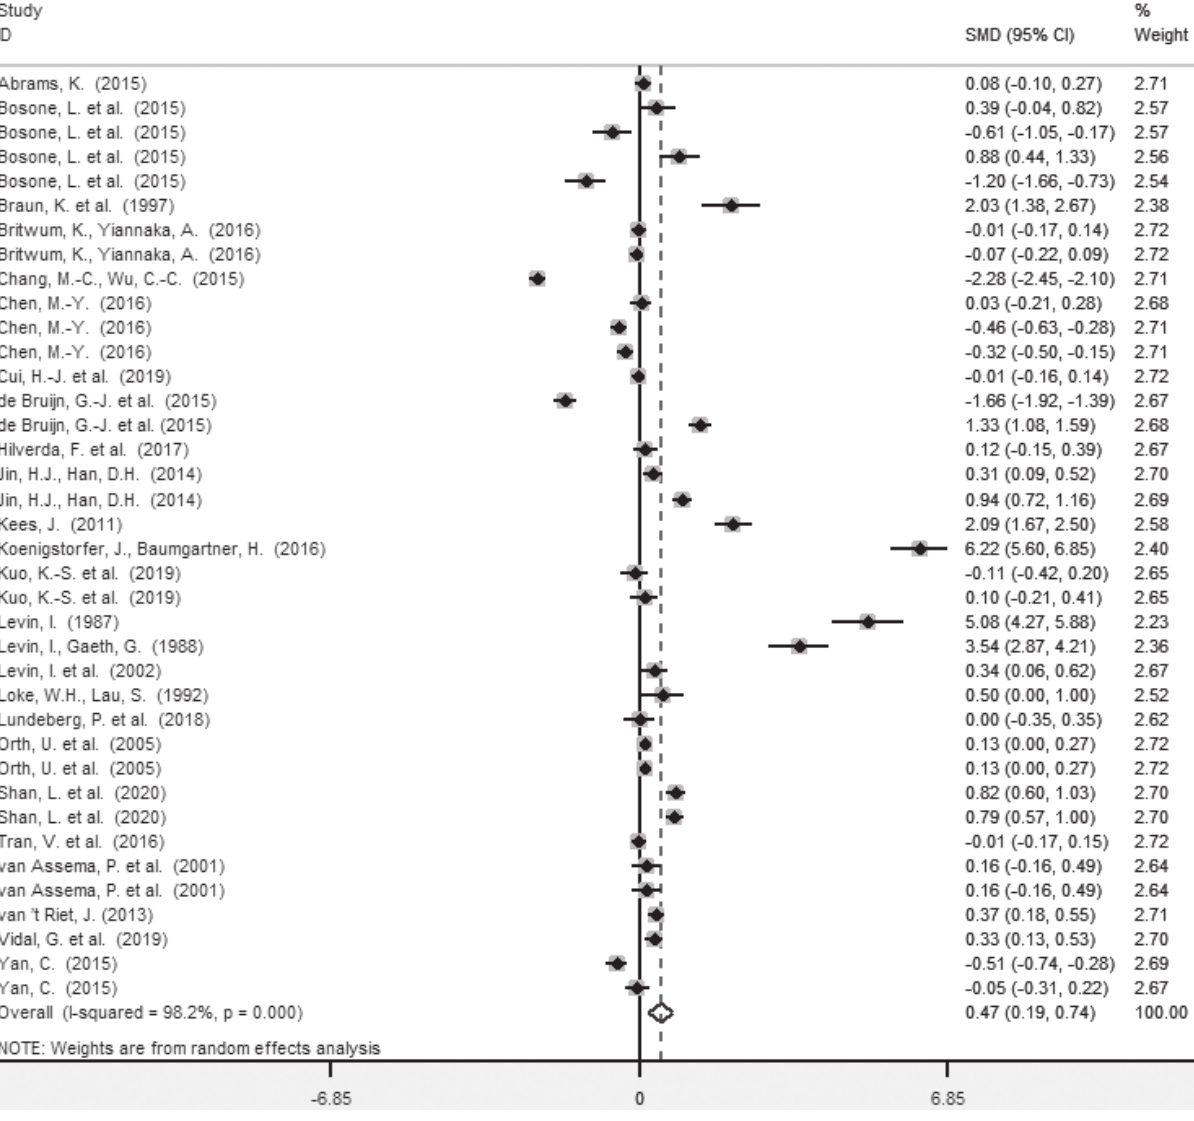
Figure 3. Meta-analysis results (whole